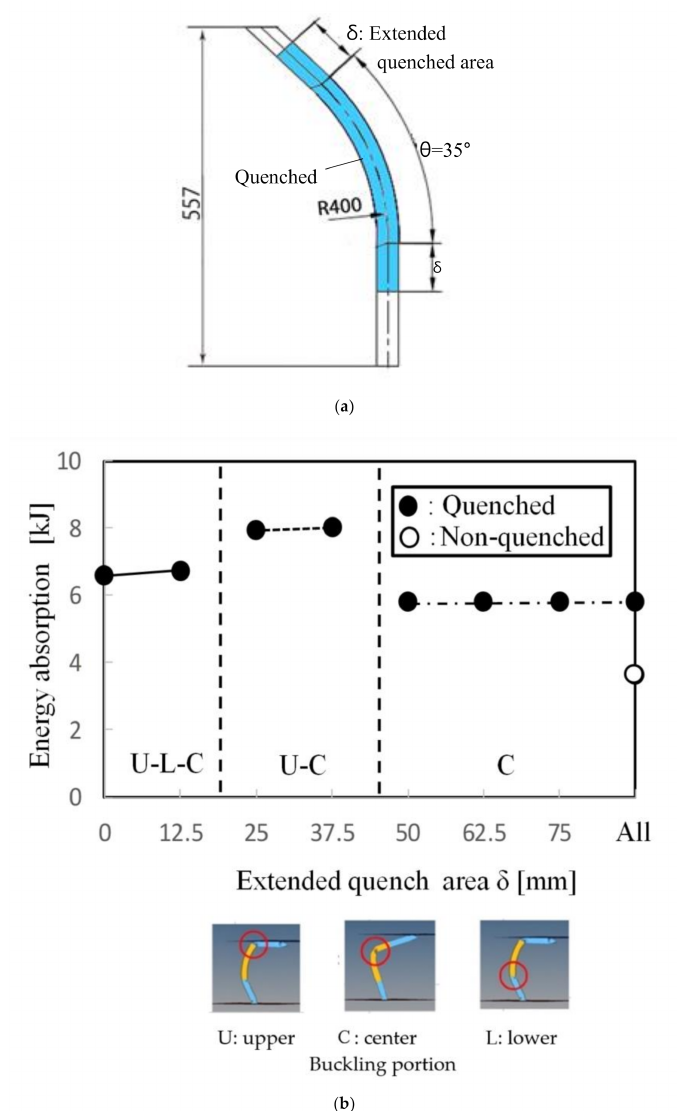
Figure 18. Relationship between the extended quenched area and energy absorption in crash test: ( a ) initial product shape and ( b ) calculation